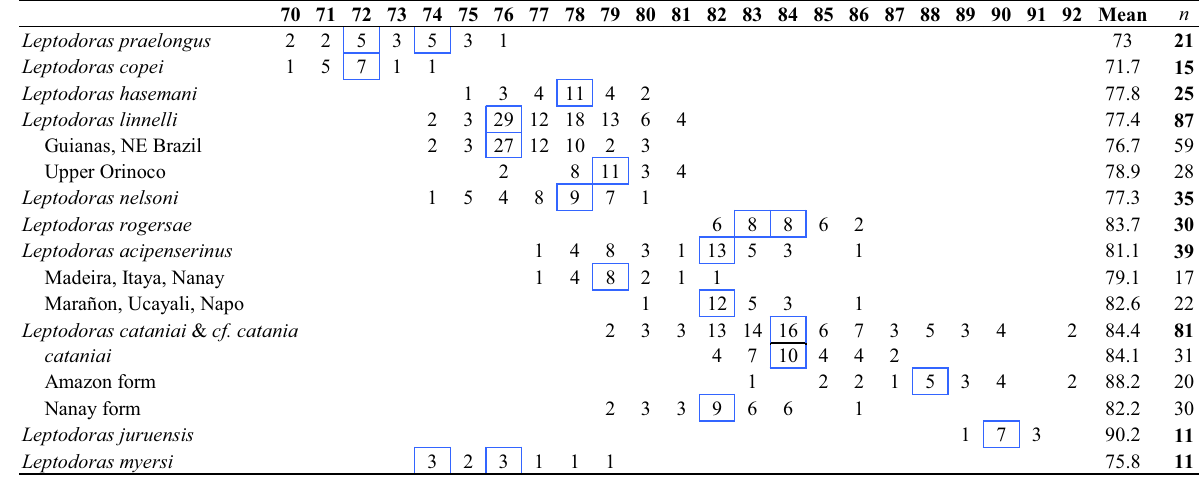
Table 3. Frequency distribution of sum of midlateral plates in Leptodoras (modal numbers in squares; count begins with infranuchal